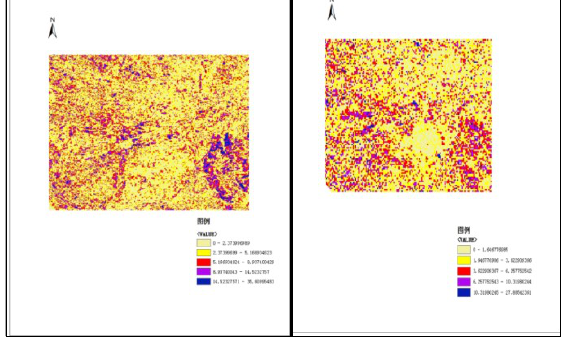
Figure 2 ASTER GDEM and WorldDEM data elevation difference spatial differentiation in test area B